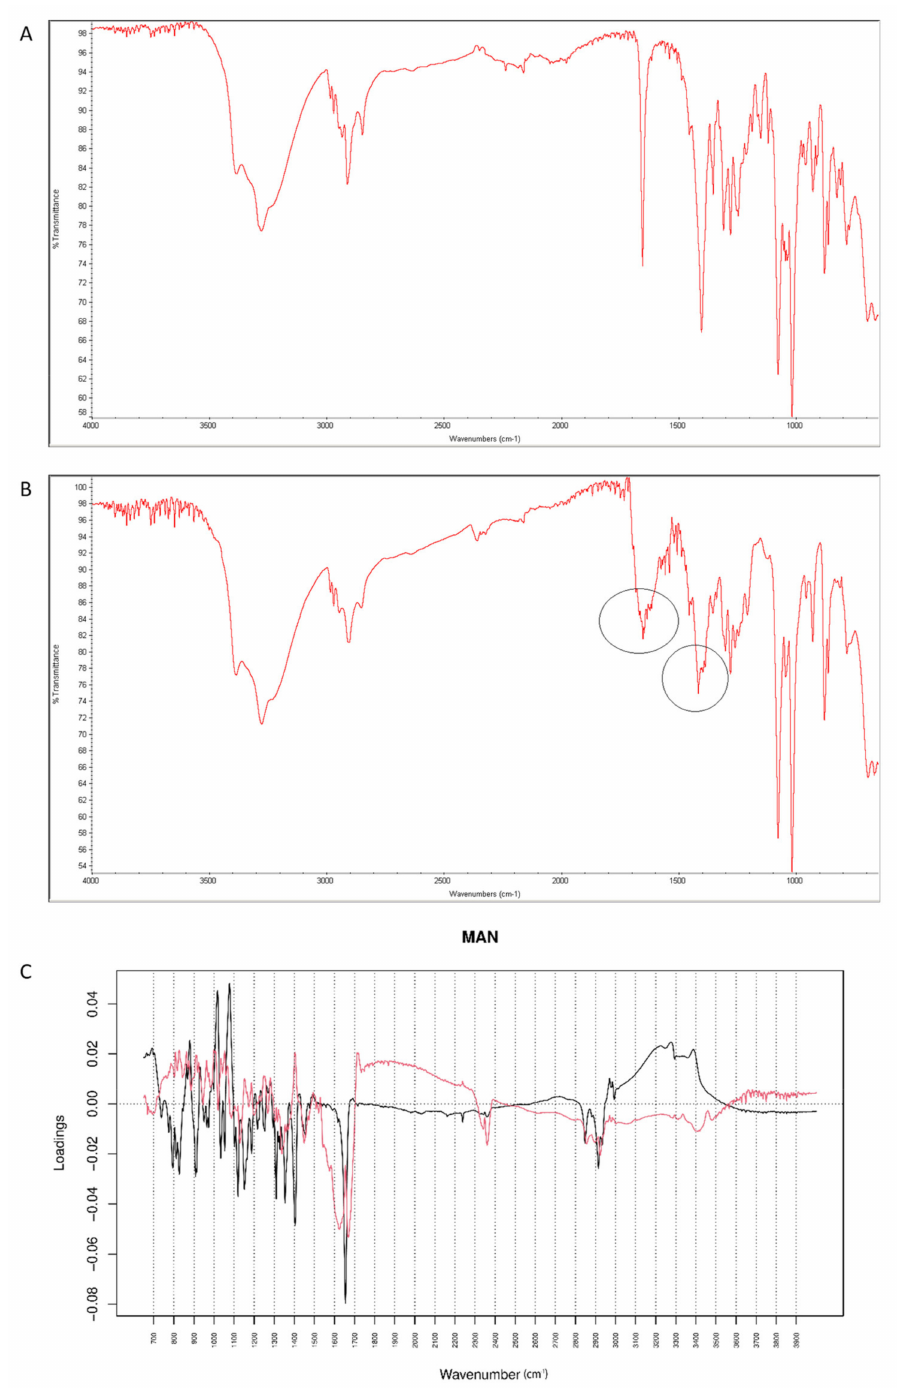
Figure 14. ( A – C ) Vildagliptin and mannitol (MAN): mid-IR spectra of no stressed mixture ( A ), stressed mixture ( B ) and PCA loadings of the spectra ( C ); PC1 loadings are marked black while PC2 loadings are marked red; most visible differences in the spectrum of the stressed mixture are indicated with